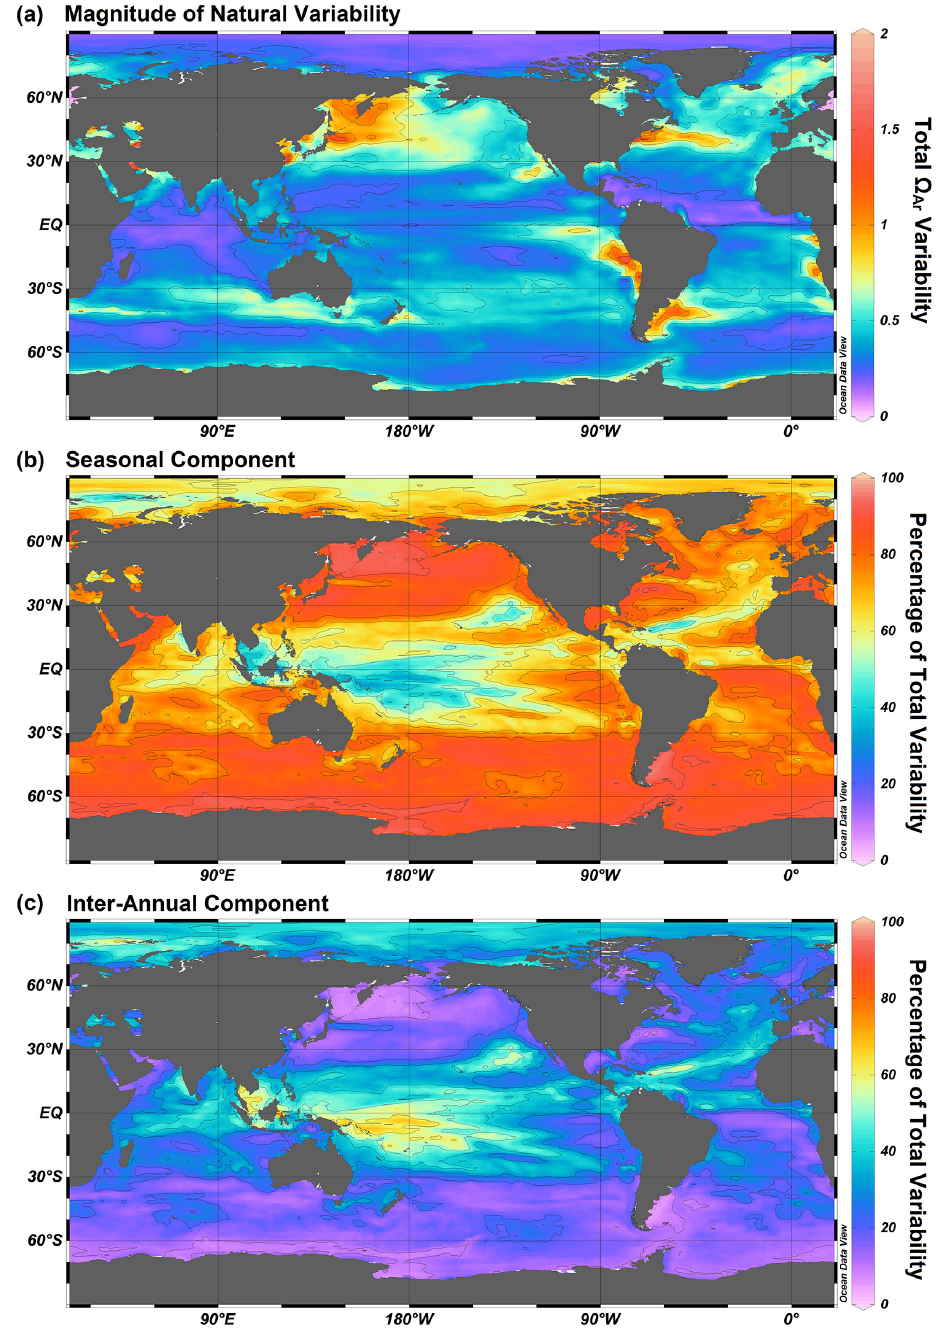
Figure 5. Model-based comparison of seasonal and interannual variability for ocean-surface (cid:127) Ar . (a) Total magnitude of variability as estimated from the ensemble of ESM. Here seasonal variability was calculated as the mean seasonal amplitude between 2006 and 2016, while IAV was calculated via the standard deviation in de-trended annual mean projections between 2006 and 2100; (b) relative contribution of seasonal variability to the total variability (in percentage); (c) relative contribution of interannual variability to the total variability (in